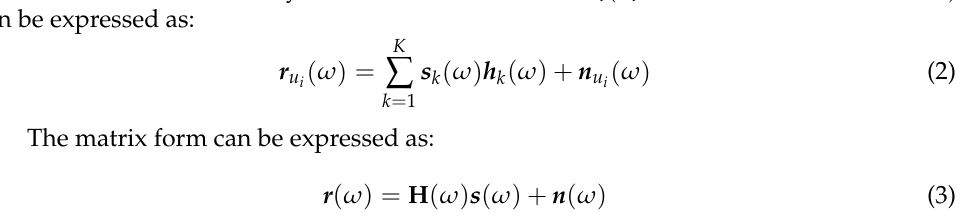
PIM Targets Figure 2. The diagram of detecting PIMs based on CS imaging.